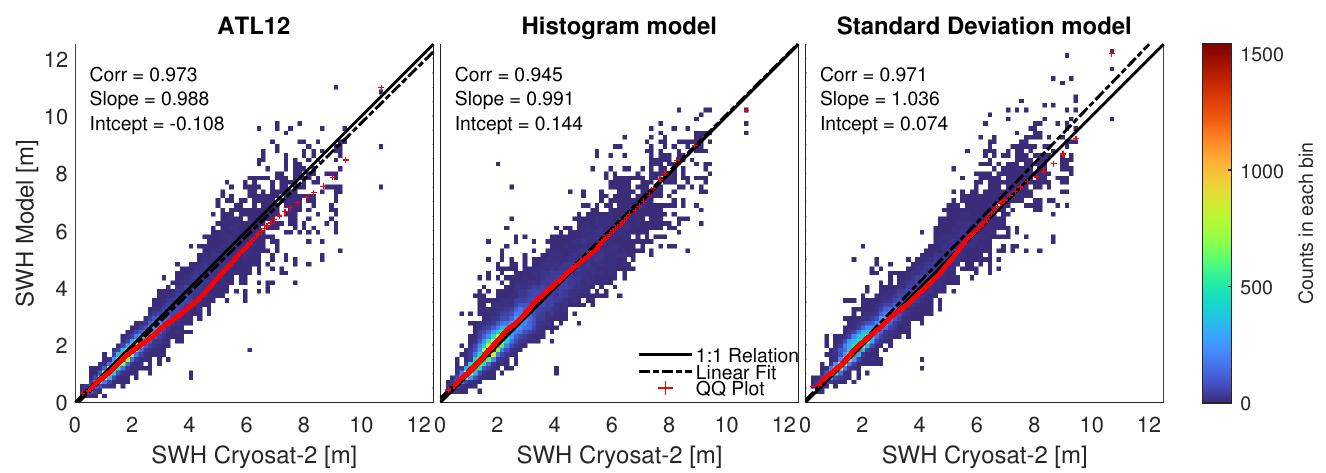
Figure 6. Density plots of the three ICESat-2 models compared to CryoSat-2, with individual points indicating low-density areas. The solid line corresponds to the 1:1 relation, and the dashed line is the least-squares linear fit. There are 36,763, 37,861, and 37,861 data points in the ATL12, histogram, and standard deviation models, respectively. The red points are the Q-Q plots.